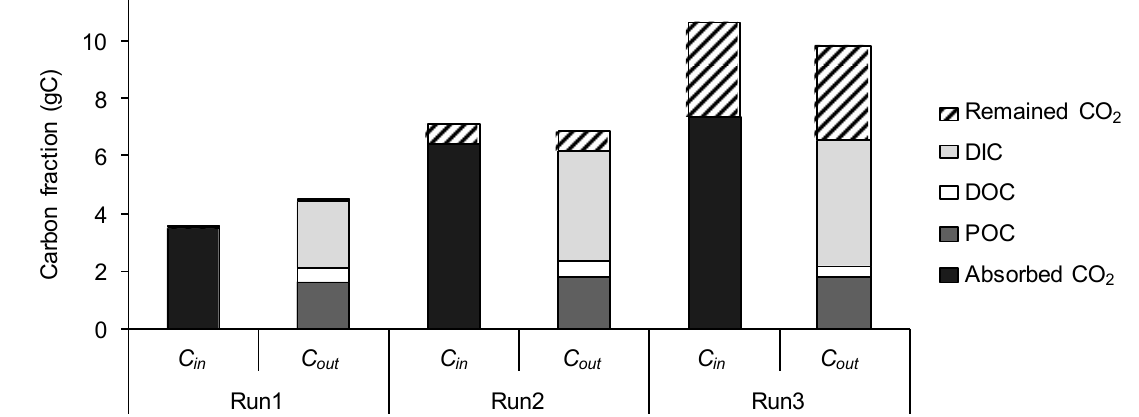
Figure 5. Carbon mass balance analysis of the experiments with CO 2 supply rate of Run 1 (16 mmol L-PBR d − 1 ), Run 2 (33 mmol L-PBR d − 1 ), and Run 3 (49 mmol L-PBR d − 1 ). C in represents a cumulative